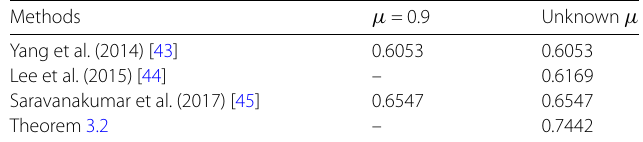
Table 1 The maximum allowable values of δ 2 for δ 1 = 0.5 and different values of μ in Example 4.1